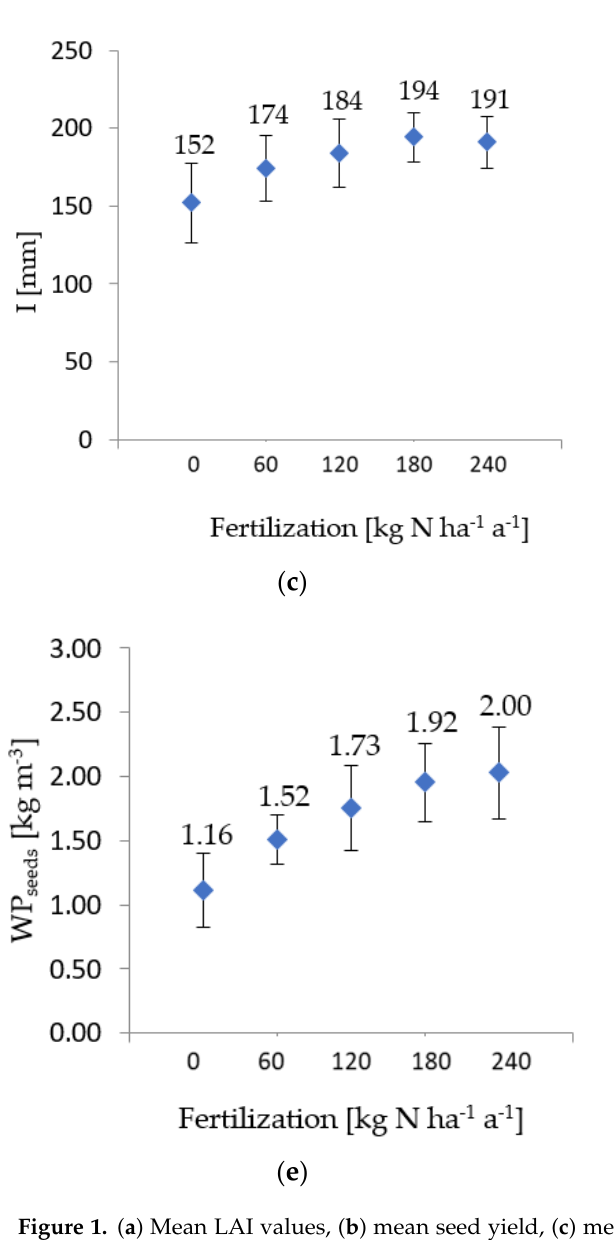
Figure 1. ( a ) Mean LAI values, ( b ) mean seed yield, ( c ) mean modeled evaporation from interception values (mm), ( d ) mean modeled transpiration (mm), ( e ) mean water productivity of the seeds (WP seeds ) each with standard deviations of the five fertilization treatments 0 (N0), 60 (N1), 120 (N2), 180 (N3), and 240 (N4) kg mineral N ha − 1 a − 1 based on the raw data ( n = 60) for the three vegetation periods 2014, 2015, and 2016.